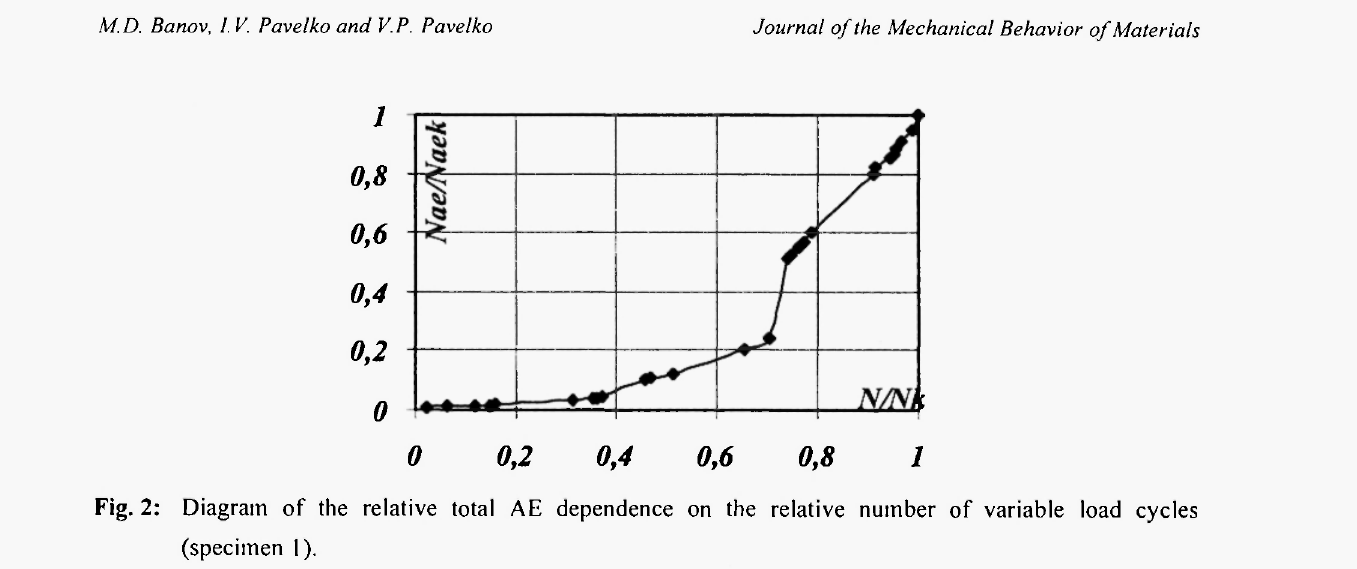
Fig. 2: Diagram of the relative total AE dependence on the relative number of variable load cycles (specimen 1).